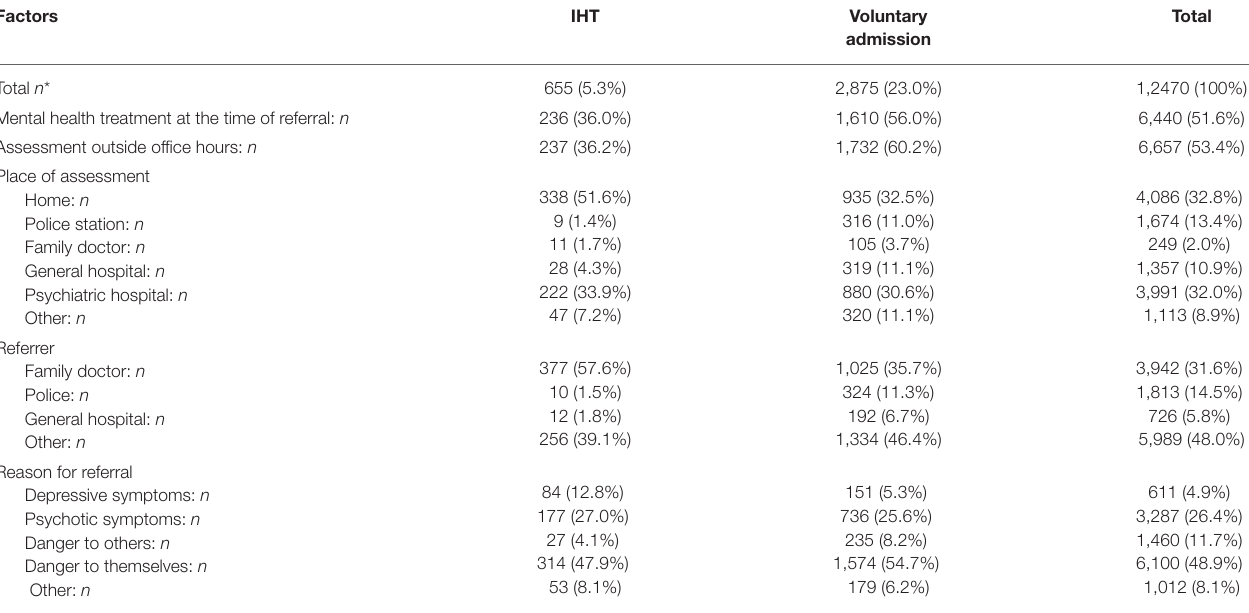
TABLE 3 | Process characteristics of patients assessed by the psychiatric emergency services. Factors